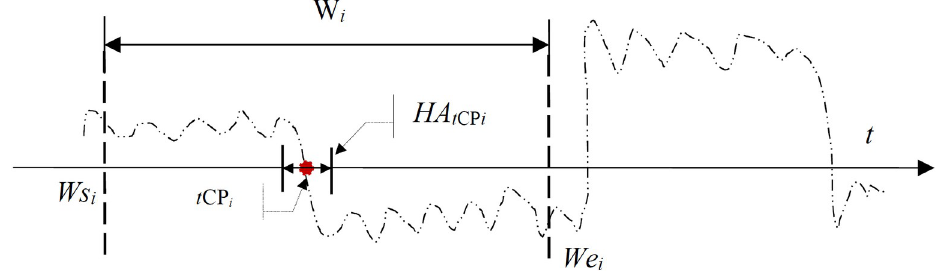
Fig 3. The scheme of single CP detection within a slide window W i under the RSW approach. The definitions of hit, error, miss and redundant are introduced according to the distance between the resultant e CP and the actual t CP